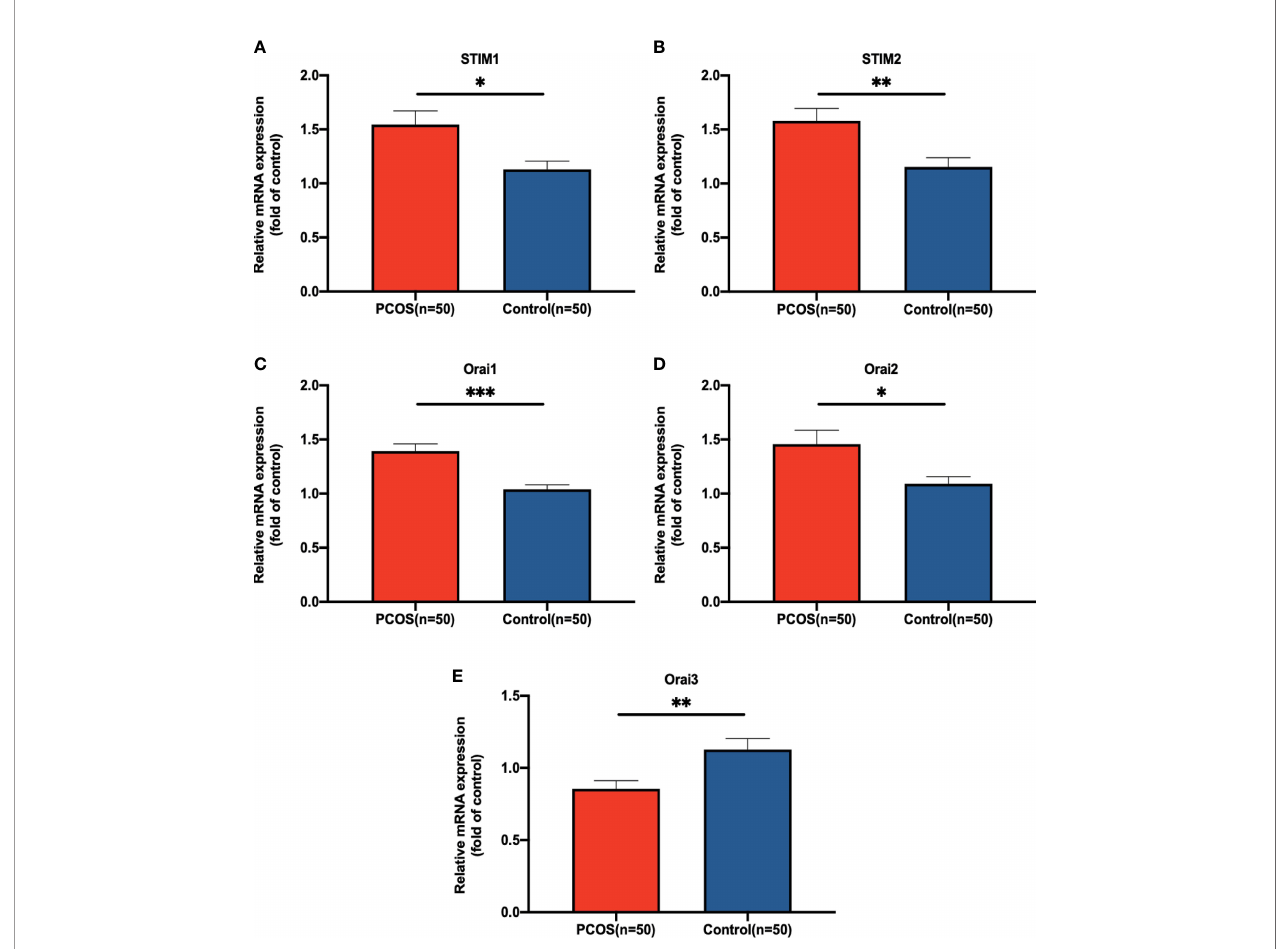
FIGURE 1 | The relative expression level of (A) for STIM1, (B) for STIM2, (C) for Orai1, (D) for Orai2, and (E) for Orai3 in GCs of patients with PCOS. The expression level was detected by qRT-PCR and normalized against GAPDH. Statistical analysis was performed by Student ’ s t-test. Data were shown as the mean ± SEM (standard error of mean). *P < 0.05, **P < 0.01, and ***P ≤ 0.001.